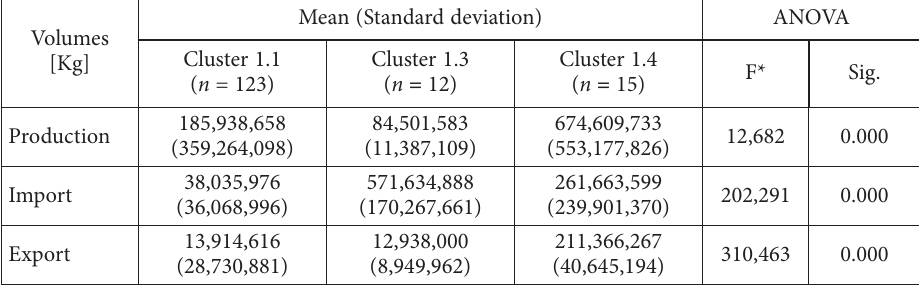
Table 10. Cluster centres and ANOVA for two-stage analysis at the s post-crisis clustering level (source: own elaboration based on COMTRADE,